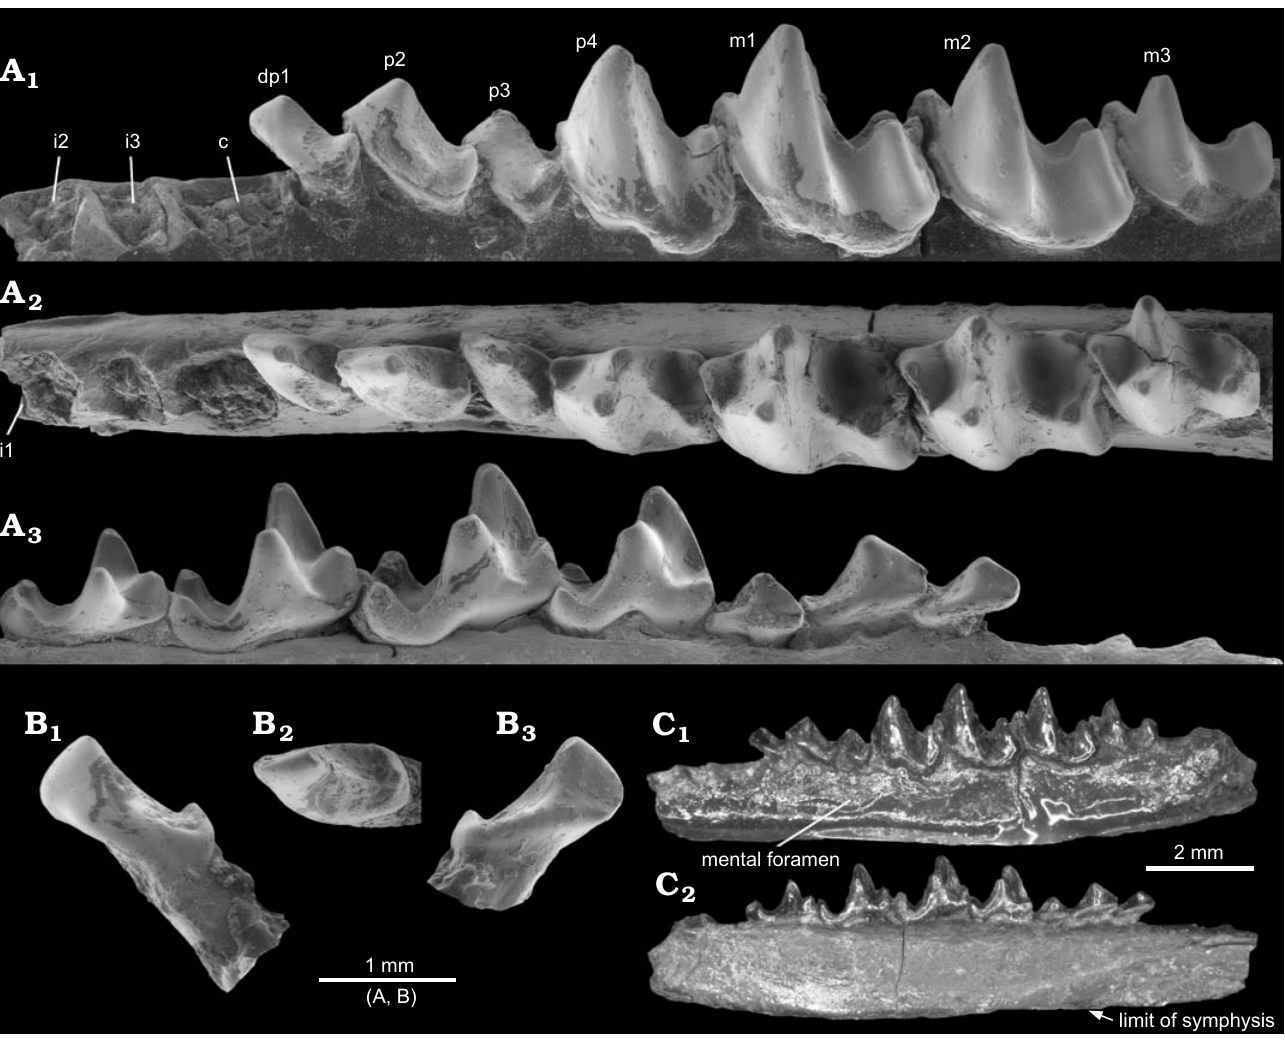
Fig. 1. Holotype of nyctitheriid euarchontan Darbonetus sigei sp. nov. (NHMUK.M10044) from the Priabonian, Eocene of La Débruge, Vaucluse, France. Left dentary with four premolars and three molars in situ, plus associated lower canine; the cheek teeth and alveoli in the dentary ( A ), the canine ( B ), the complete dentary ( C ); in buccal (A light micrographs